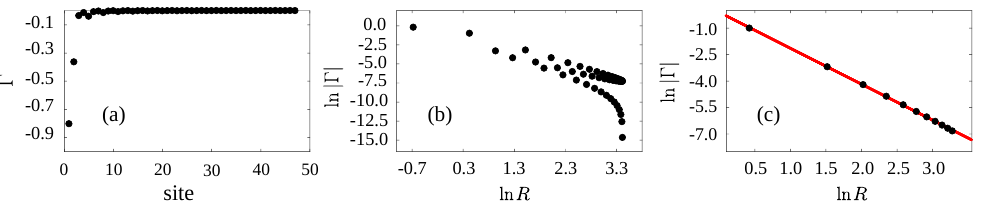
Figure 4 . Spin-spin correlation function (cid:0) of the SU(3) model with L = 47. (a) (cid:0) j on all sites. (b) Log-log plot of j (cid:0) j j versus R j = 2( L +1)